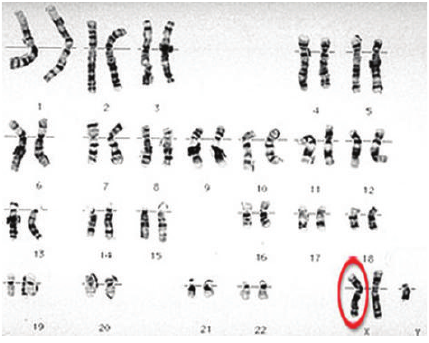
Figure 1: Karyogram of patient with KS suggests a 47XXY kary- otype.